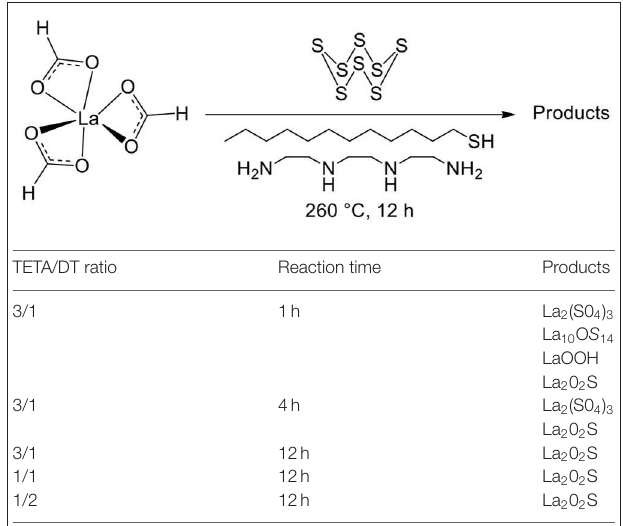
FIGURE 16 | Reaction of Ma et al. (2013) to yield La 2 O 2 S nanoparticles.